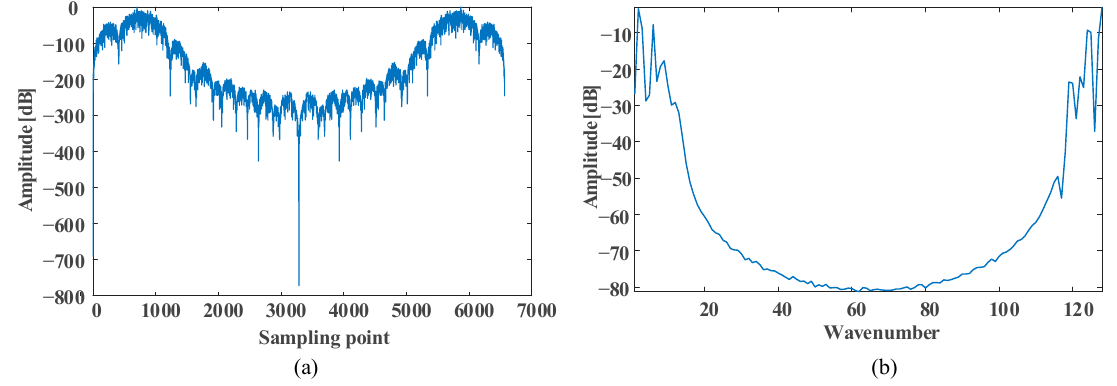
Figure 3. ( a ) Spectrum of the 32nd sampling line after FFT, ( b ) spectrum of the 10th line of echo signal parallel to transducer in the wavenumber domain after FFT.